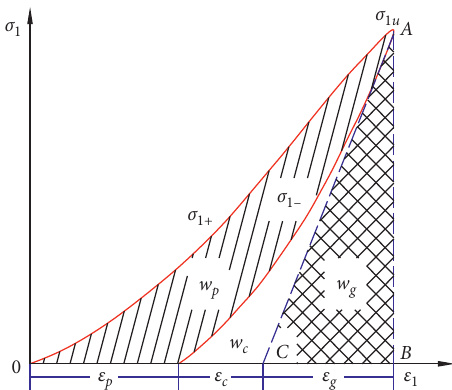
Figure 2: Classification and calculation of strain